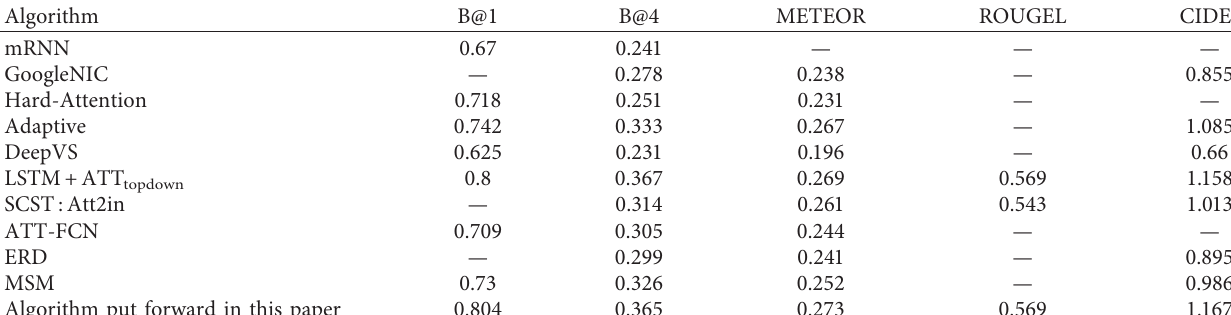
Table 3: Comparison of the scores obtained by different generation algorithms for multimedia image description.